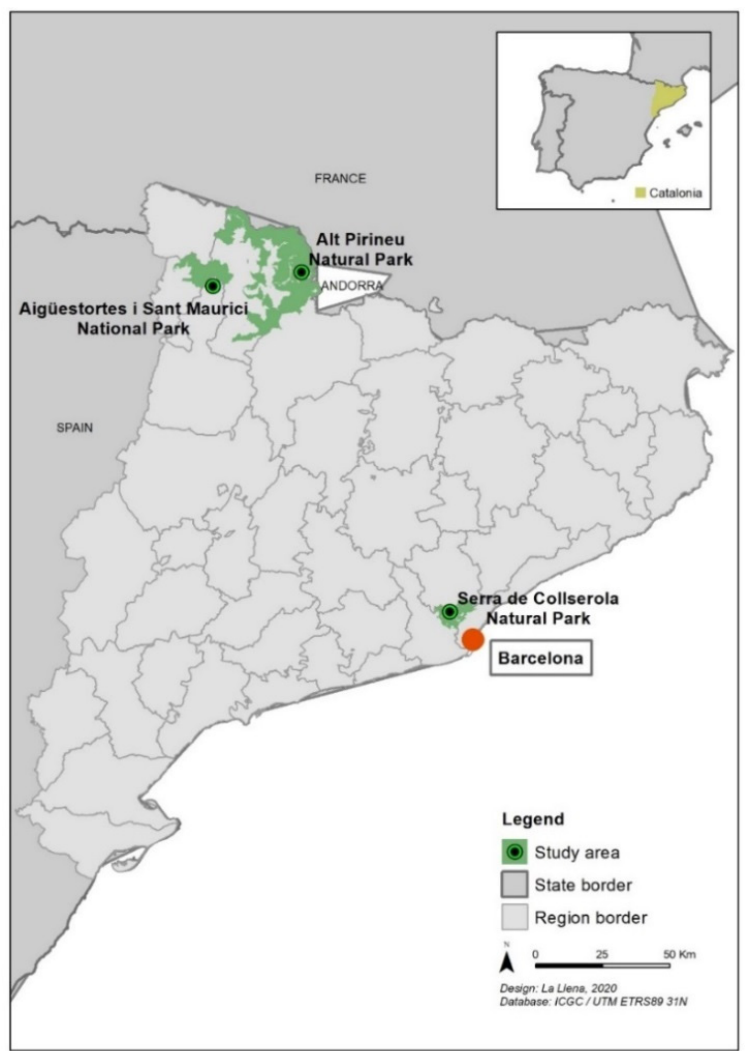
Figure 2. Location of the three protected natural area studies: Aigüestortes i Estany de Sant Maurici National Park, Alt Pirineu Natural Park and Serra de Collserola Periurban Park.